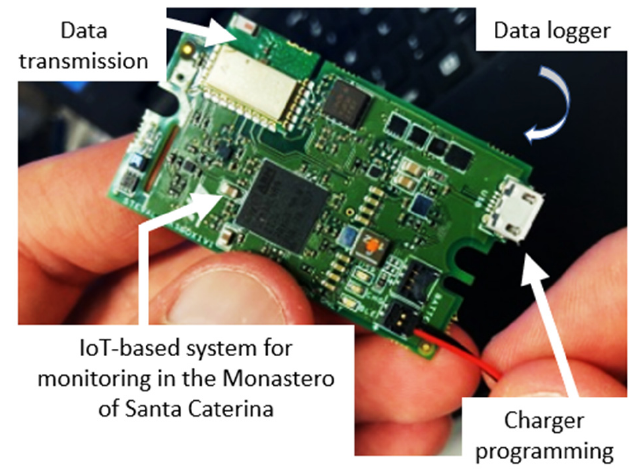
Figure 3. Board used for the monitoring of the painting. Table 2. Characteristic of the sensors.